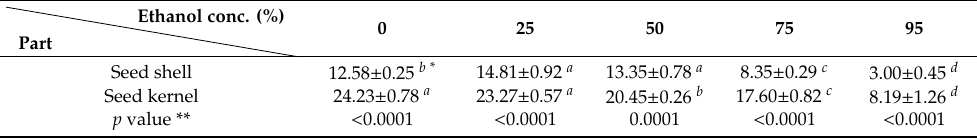
Table 1. Extraction yield (%) of seed shells and kernels with di ff erent ethanol